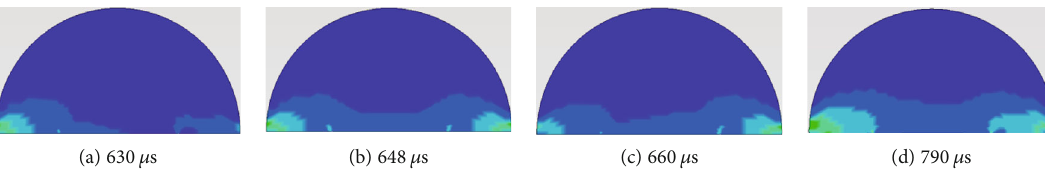
Figure 9: Stress distribution in CSTBD specimens at di ff erent times.